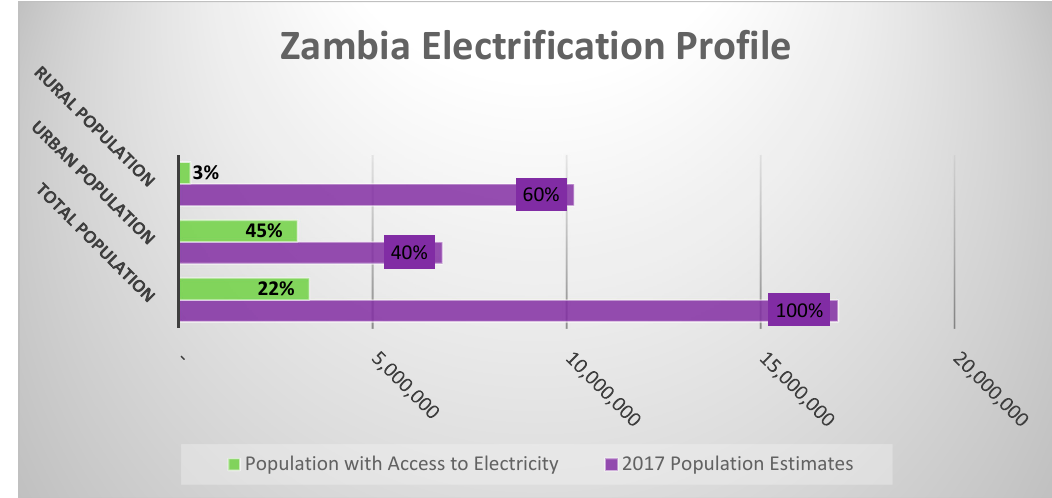
Figure 1. Statistics used above were extracted from the Renewables Readiness Country Assessment [15] and the local statistical bureau [18].